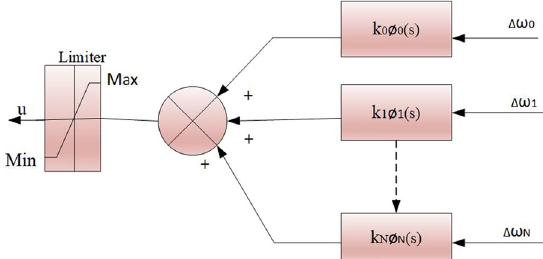
Fig. 7 GSC SDC with multichannel gain and phase shifters